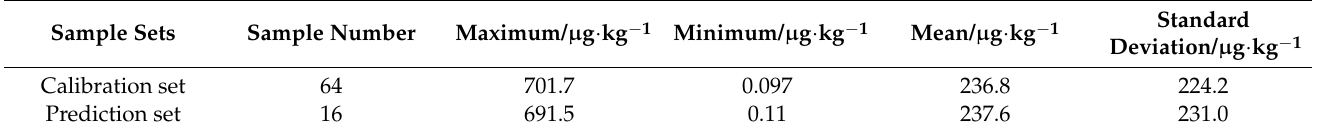
Table 1. Statistical results of the AFB 1 value of peanut oil samples in the calibration set and the prediction